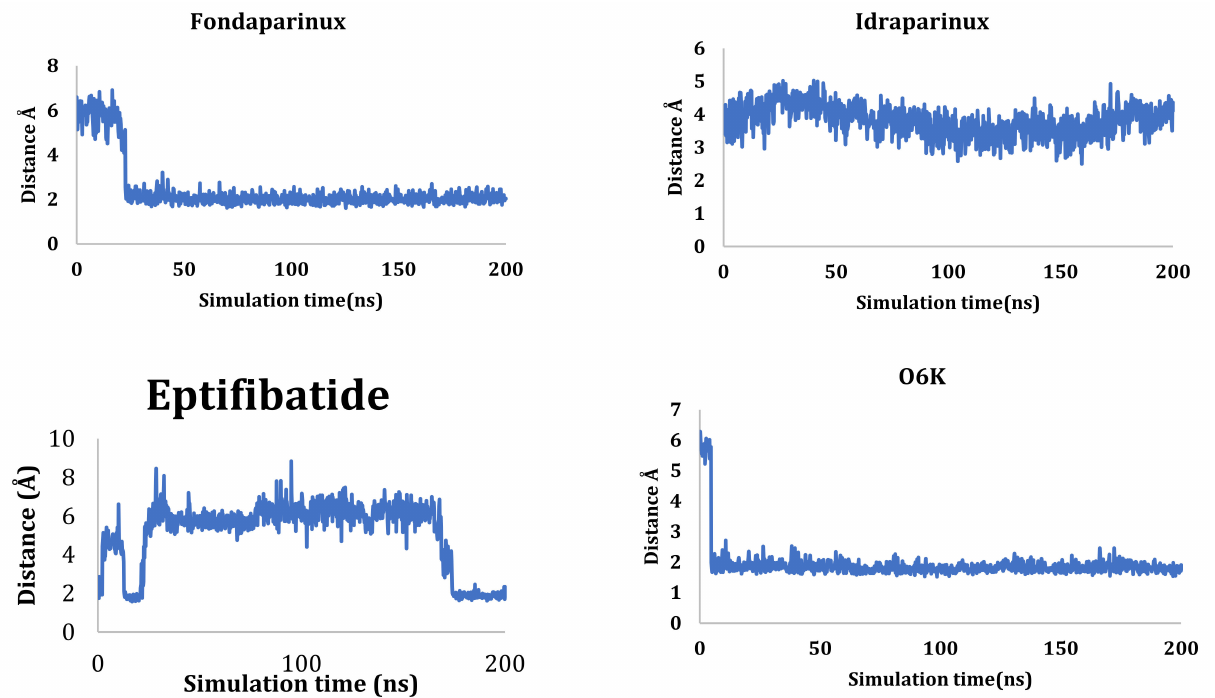
Figure 5. Distance in Å between Glu166 residue and ligands during the MD simulation using the measurement panel in Maestro